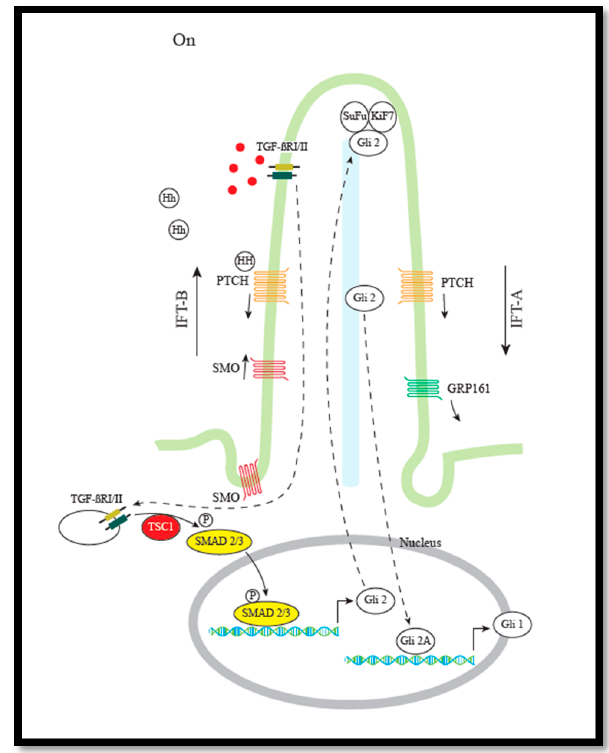
Figure 3. Hh and mTOR crosstalk via TGF β signaling. The TGF- β -activated TGF- β receptor complex (TGF- β I/II) activates, by phosphorylation, the GLI2 transcription factor SMAD2/3. For this activation, TSC1 is required. See text for further details.